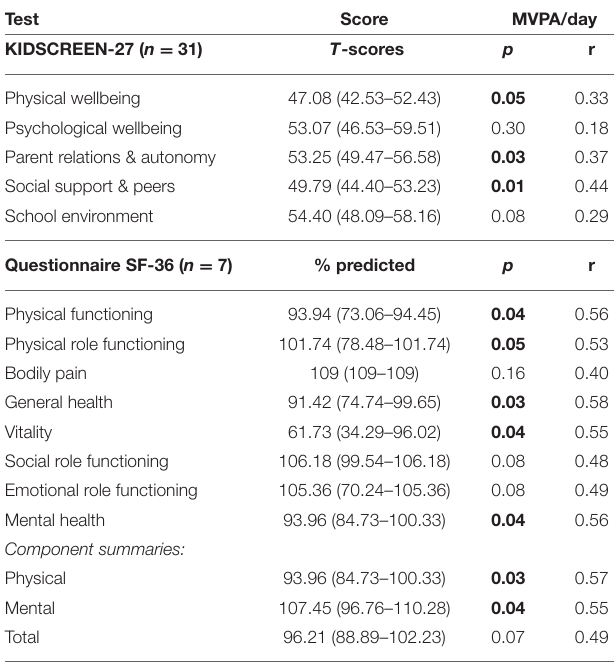
TABLE 3 | Results of the SF-36 and KIDSCREEN-27 questionnaires and correlation with